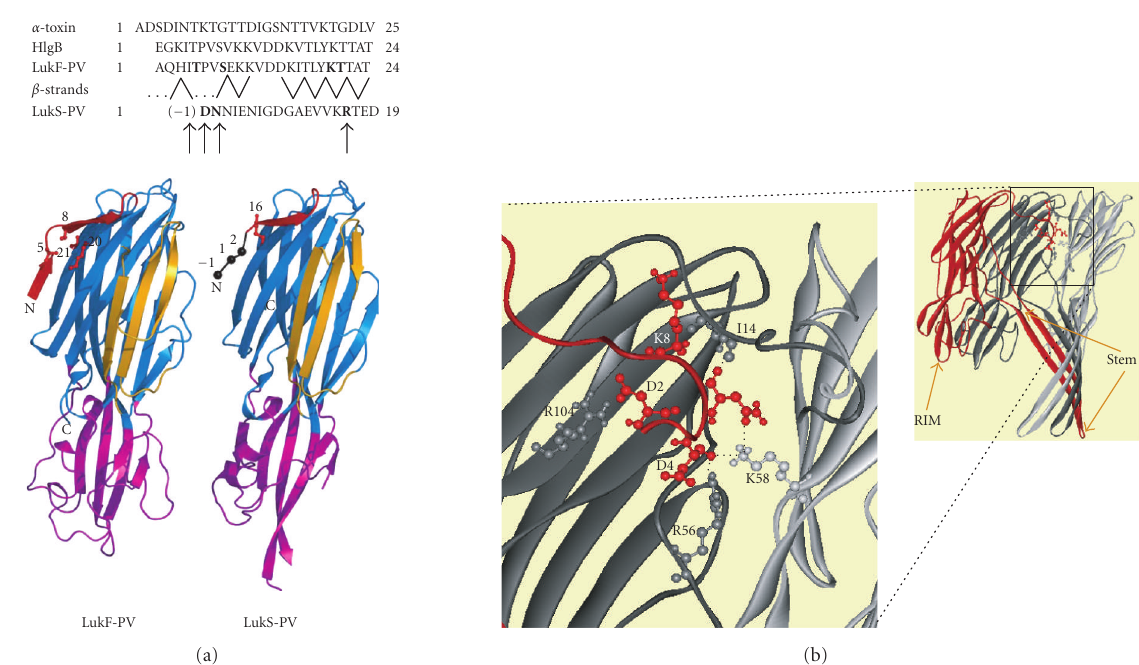
Figure 1: Structural features of the N-terminal extremities of staphylococcal bipartite leukotoxins and α -toxin. (a) Sequence alignment of the N-termini of staphylococcal α -toxin and of the two components LukF-PV and LukS-PV of the Panton-Valentine leucocidin. The strands arrangement of LukF-PV is indicated by dashes. Cysteine-substituted residues, indicated in bold in the sequences, are also shown on the 3D structures of LukF-PV (PDB code 1pvl) and LukS-PV (PDB code 1t5r). (b) For comparison, view three protomers of the α -toxin heptamer (PDB code 7AHL) and polar interactions involving the N-terminal extremity of a given subunit (red) with residues of two adjacent protomers (grey and dark grey) within the α -toxin pore